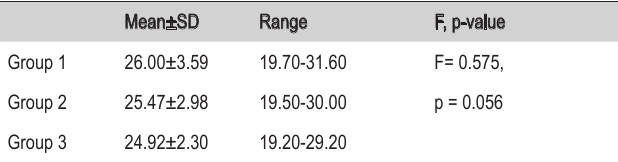
Table 1 - Comparison of the mean bond strength to dentin in the study groups (in